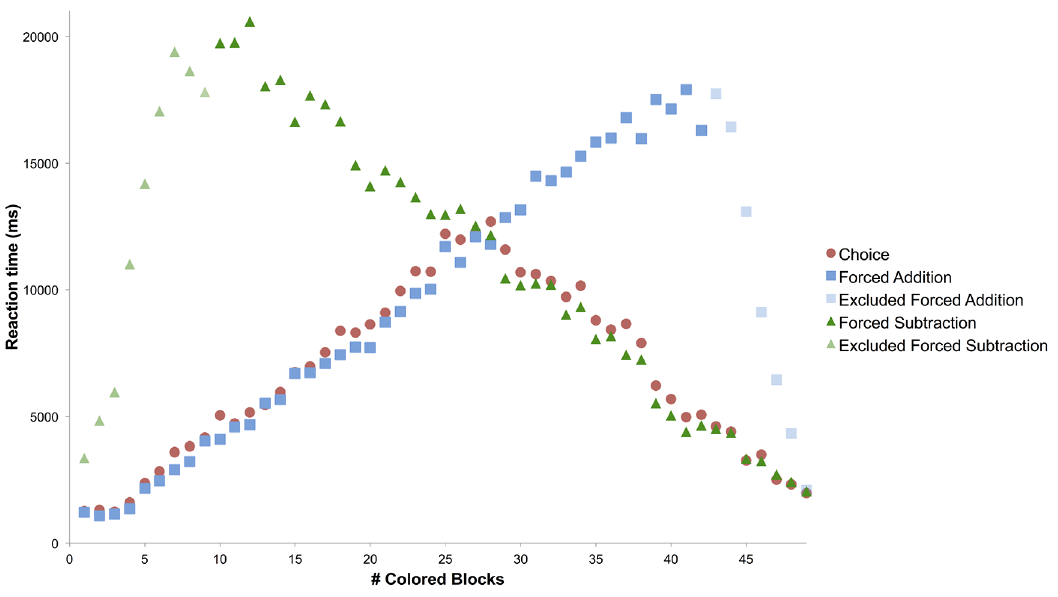
Figure 5. Reaction times (ms) of the numerosity judgment task averaged across participants per condition. Note. The greyed-out colors represent the average excluded trials of the no-choice conditions. Note that the average reaction times are depicted on this figure, while the individual RTs, change points and number of excluded trials differed per